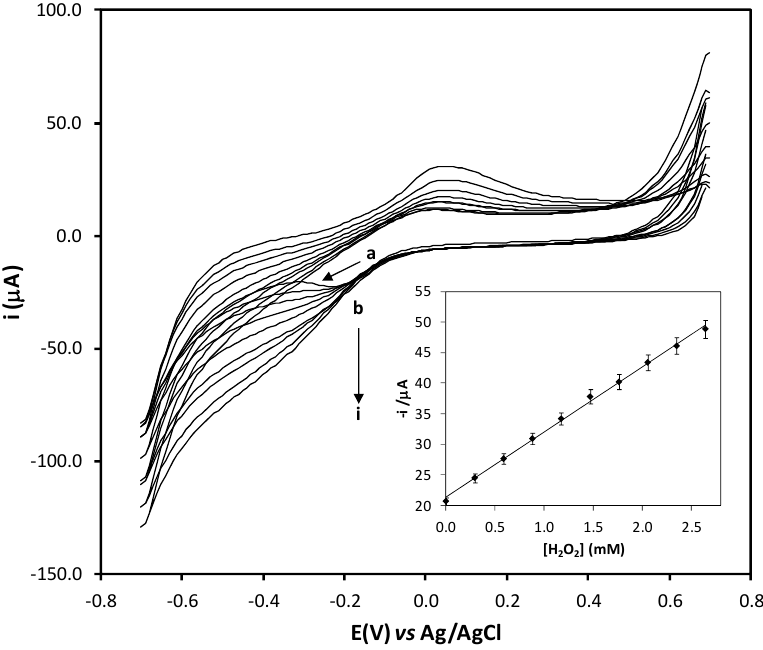
O concentrations from 0.0 to 2.6 mM. 2 2 O ] (mM). 2 2